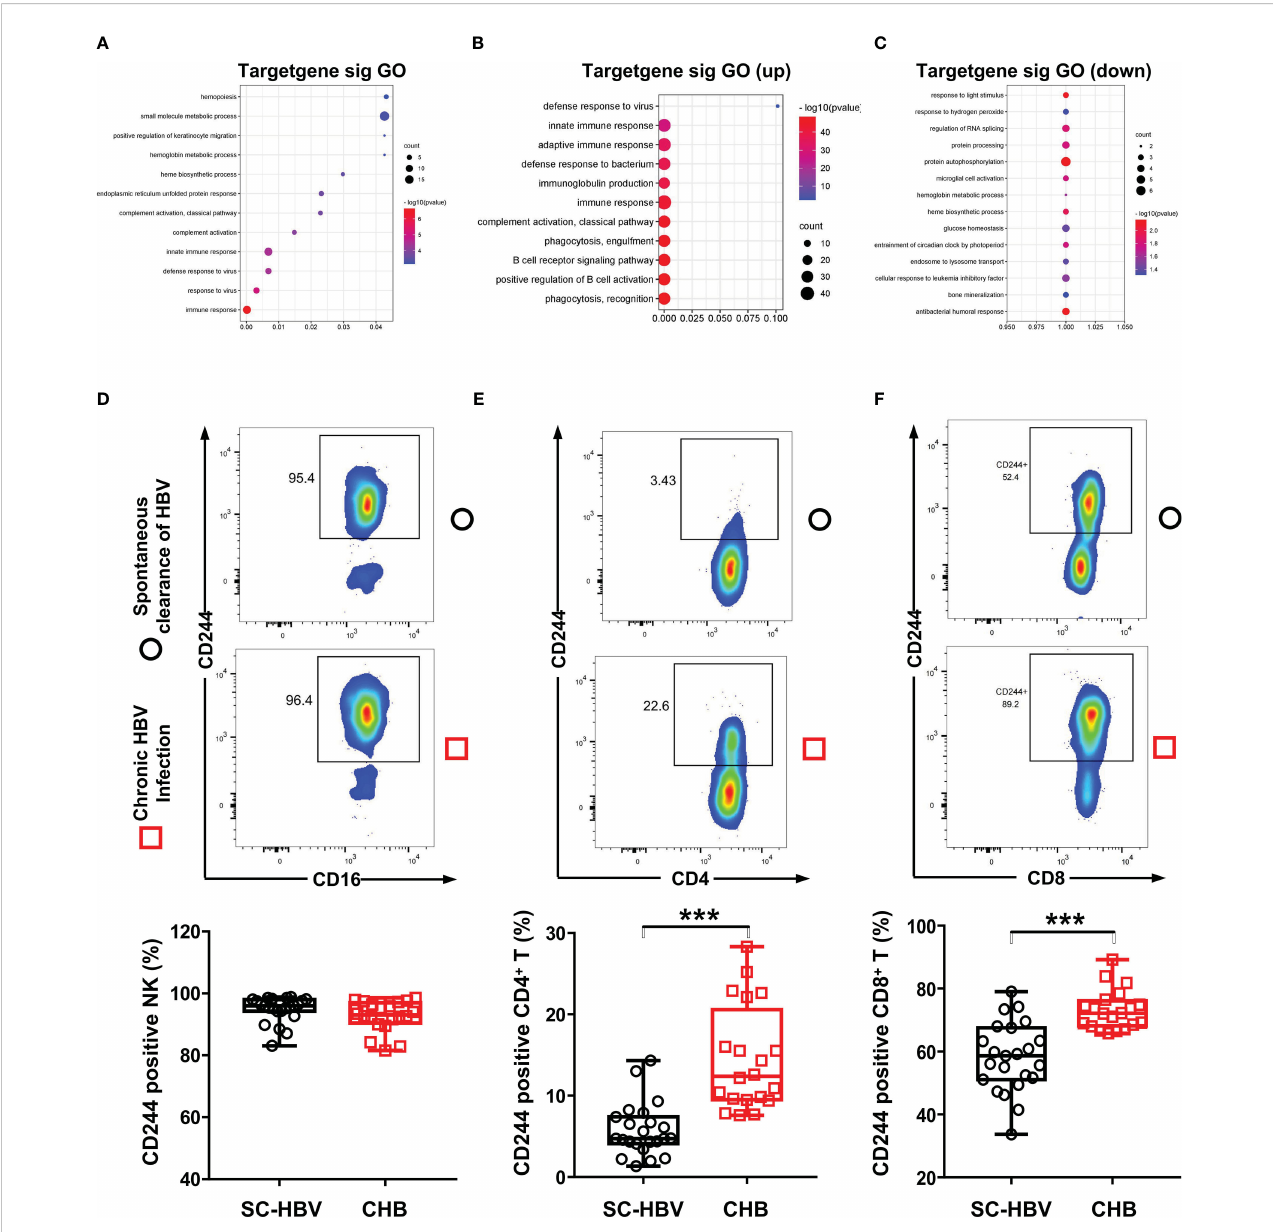
FIGURE 2 CD244 signaling expression on immune cells in CHB patients and SC HBV controls. (A) GO enrichment analysis of all signi fi cant genes, ( P < 0.05). GO: Gene Ontology. (B) GO analysis for upregulated genes classi fi ed as signaling molecules. (C) GO analysis for downregulated genes classi fi ed as signaling molecules. (D-F) Activation and expansion of CD244 on NK cells (D) , CD4 + T cells (E) and CD8 + T cells (F) were analyzed by fl ow cytometry. Data (CHB, n = 20; SC HBV, n = 23) were analyzed using Student t test, *** P <